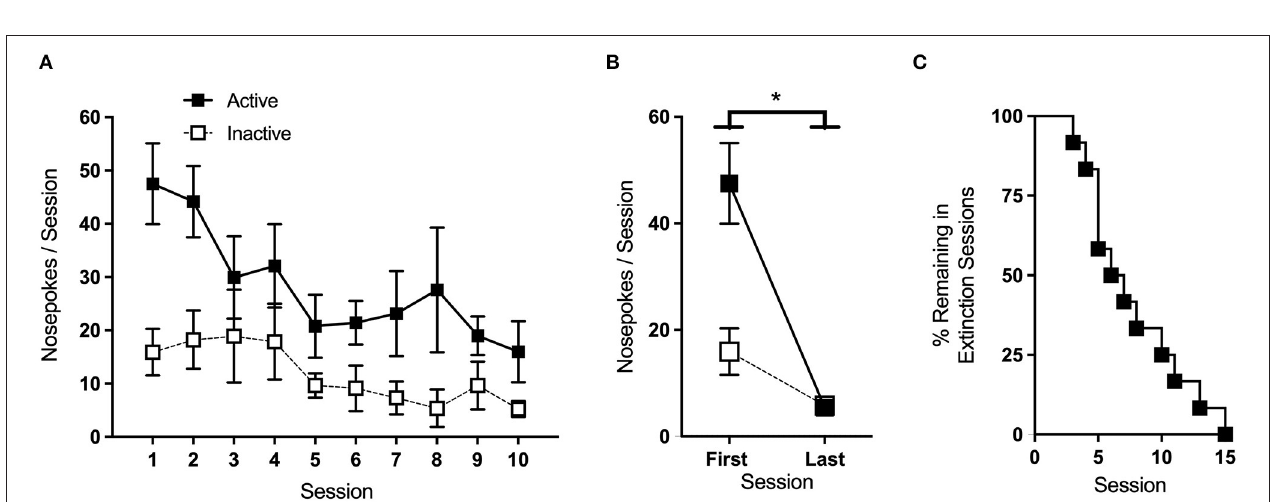
FIGURE 7 | Extinction. (A) Average nose-pokes (active port, large boxes; inactive port, and small boxes) during extinction sessions where > 25% of animals remained. (B) Mice made significantly fewer nose-pokes on the last day of extinction compared to the first. (C) The rate at which animals met the criteria and progressed to the next phase of testing. * p < 0.05; n/group = 12; data shown are mean ± SEM. Modified from Huebschman et al., 2021, with permission from Wiley and the Federation of European Neuroscience Societies. The figures include data collected with support from the NIDA Drug Supply Program (gifted drug) and Texas A&M University